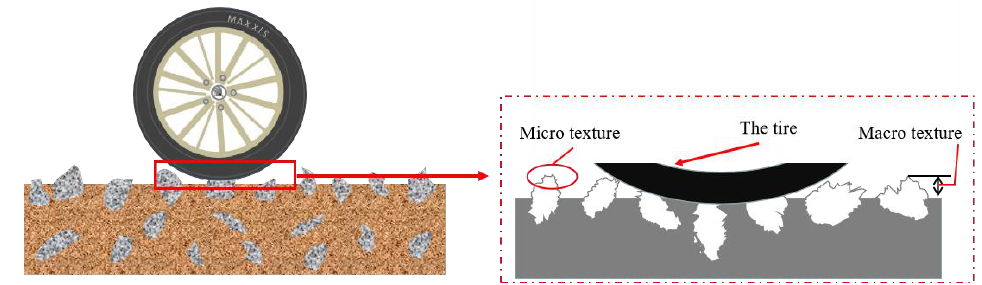
Figure 1. The schematic diagram of tire contact with road surface.